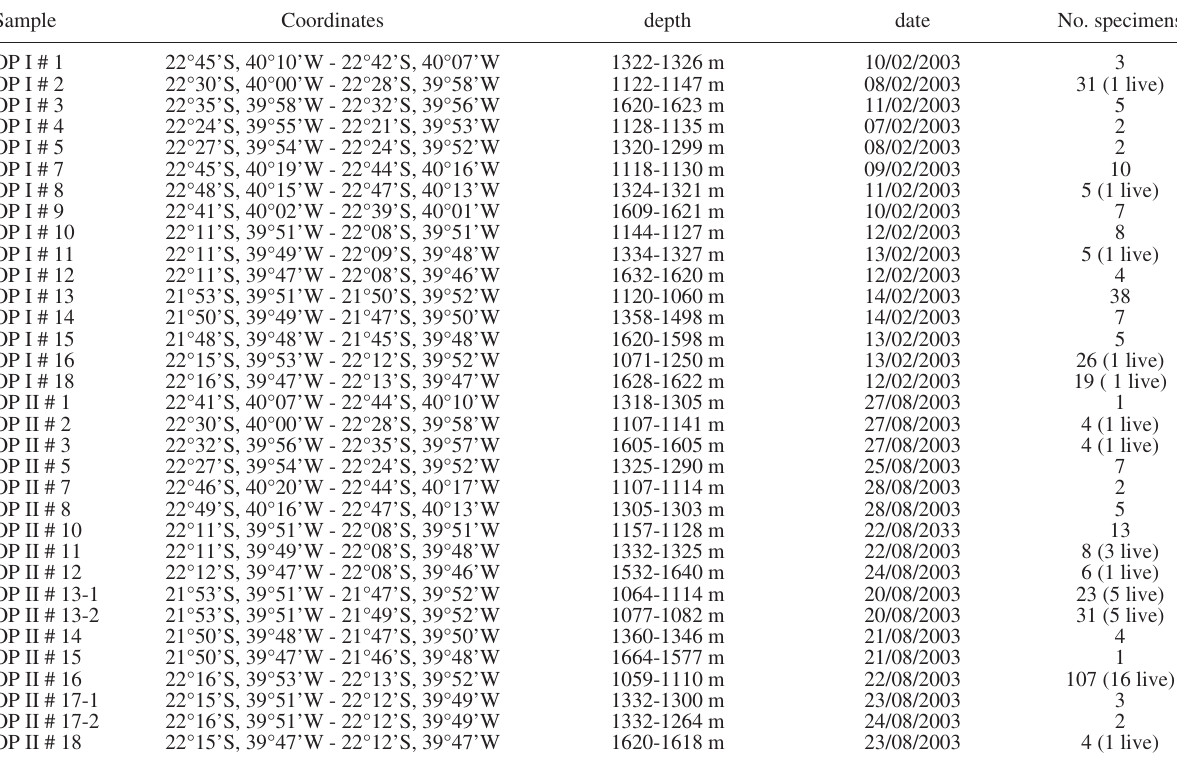
Table 2. – Geographical data for stations sampled with a Charcot dredge. Nº specimens refers to those belonging to the studied subfamilies.